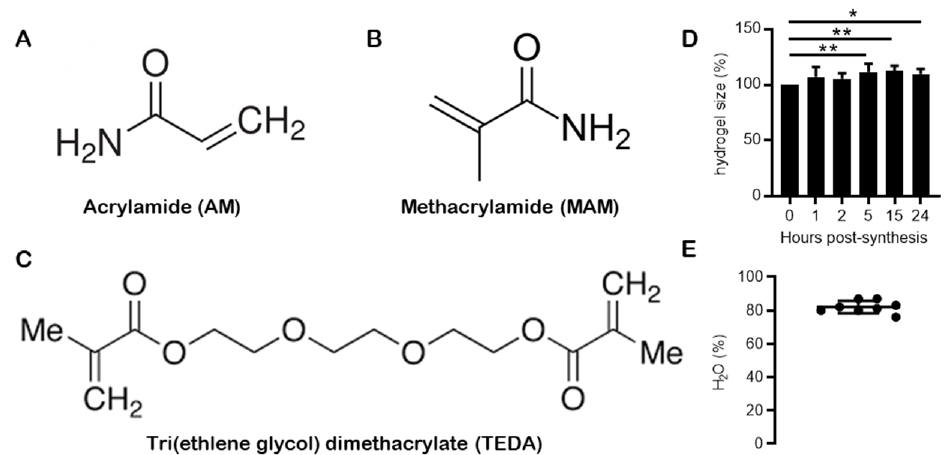
Figure 1. Physical description of high refractive index hydrogels. The chemical structures of acrylamide ( A ), methacrylamide ( B ) and tri(ethlene glycol) dimethacrylate ( C ) are shown. Changes in hydrogel size following synthesis and immersion in PBS for 24 h were measured ( n = 8) ( D ), together with the water content of high refractive index hydrogels ( n = 8, each point is an independent experiment) ( E ). Values ( D , E ) representing the mean ± SD and results were analysed by one-way ANOVA with Dunn’s multiple comparison’s test. * p < 0.05, ** p < 0.01.